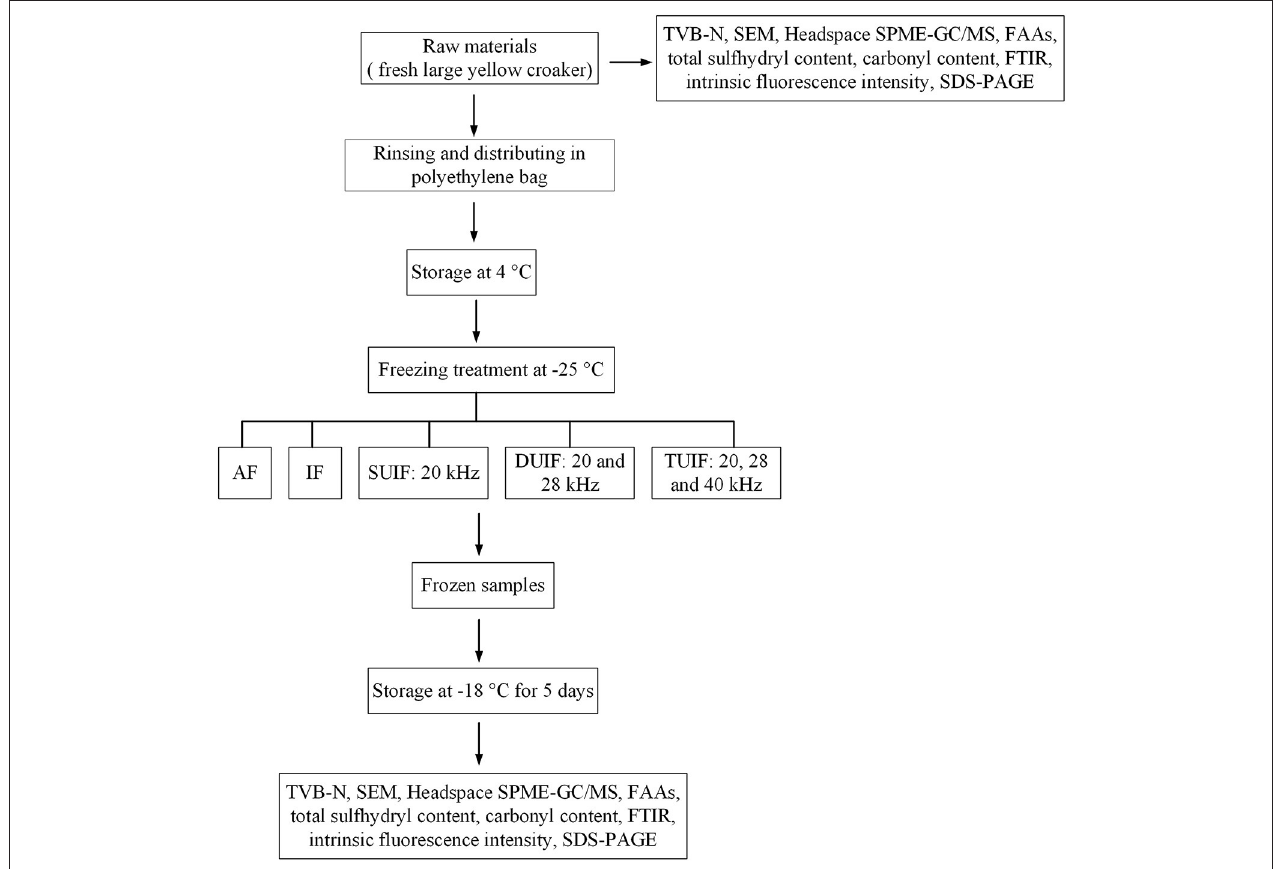
FIGURE 1 | Flow diagram of experimental